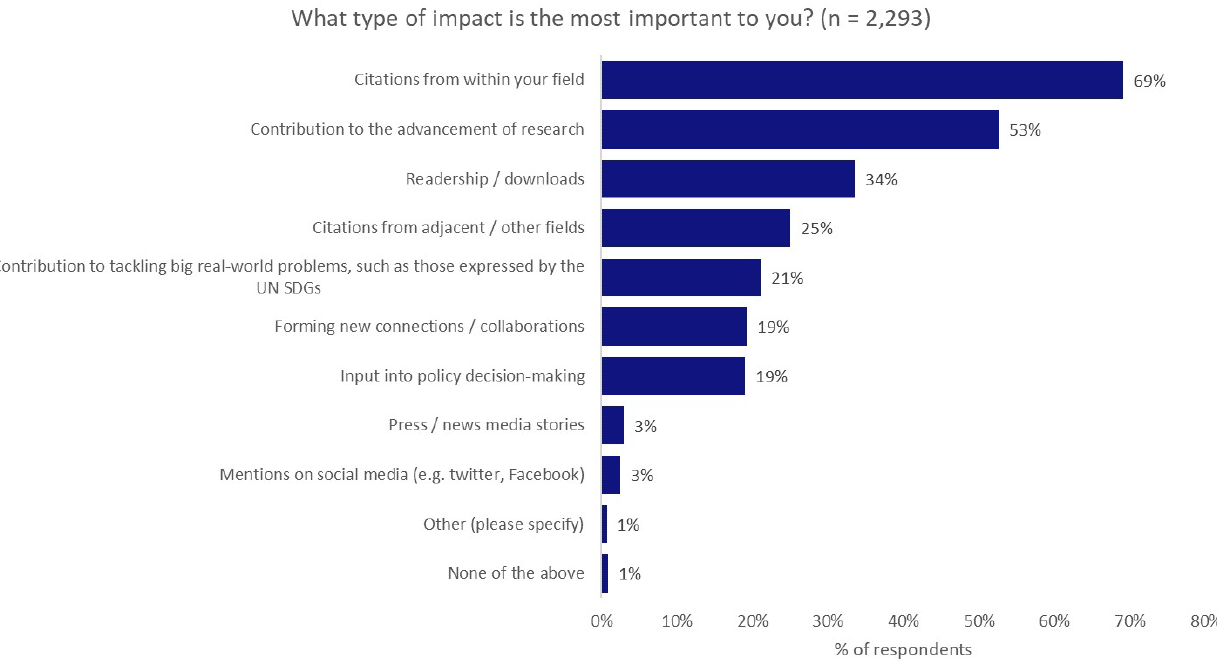
Figure 4. Most-preferred type of impact (maximum of three